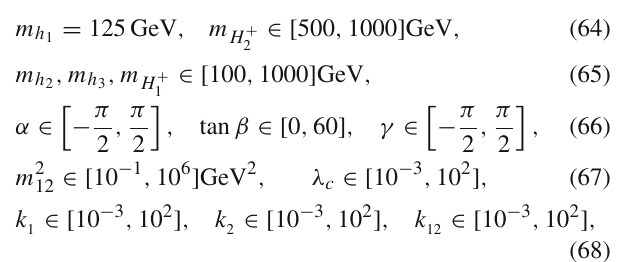
lation between α and β . We see that all the points satisfy | cos (β − α) | (cid:2) 1, that is they are close to the alignment limit, where the 125 GeV neutral scalar has couplings equal to their SM values. The points with negative α correspond to the wrong sign of the fermion couplings [38,39]. We also see that despite having varied tan β in a larger interval, the good points have tan β ∈ [ 1 , 10 ]